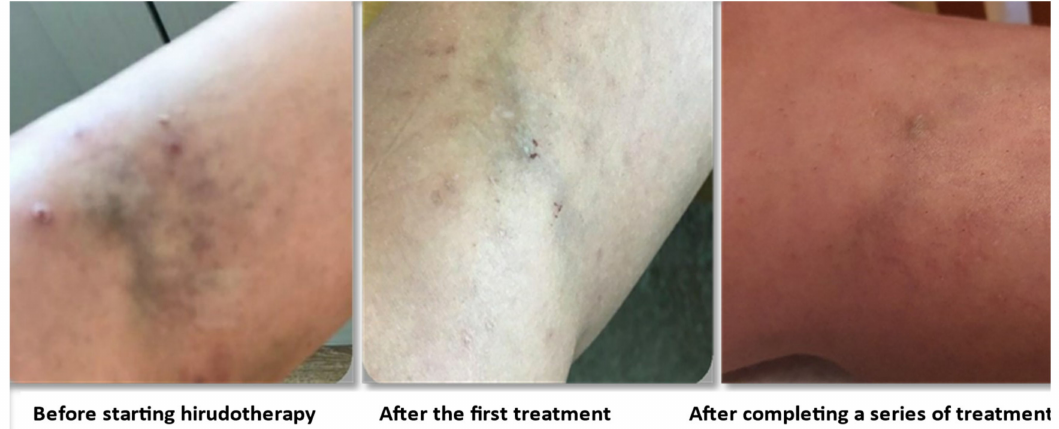
Figure 4. The effects of leech therapy in the fight against varicose veins (from the left: before the therapy, during the therapy, and after the end of the series of treatments). Source: materials provided by one of the experts (with the consent of the